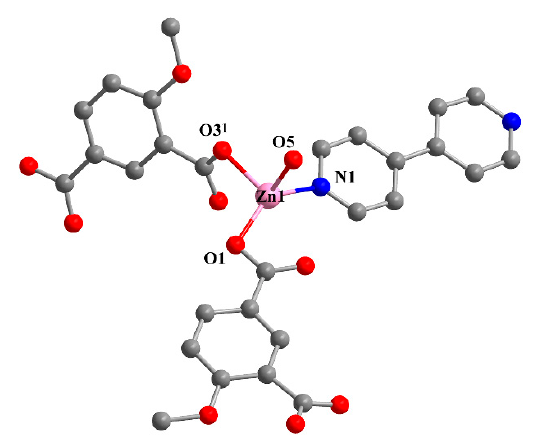
Figure 2. The coordination environment of Zn1. All hydrogen atoms and guest molecules are omitted for clarity. Symmetry code: (1) x , 1 − y , 0.5 + z .